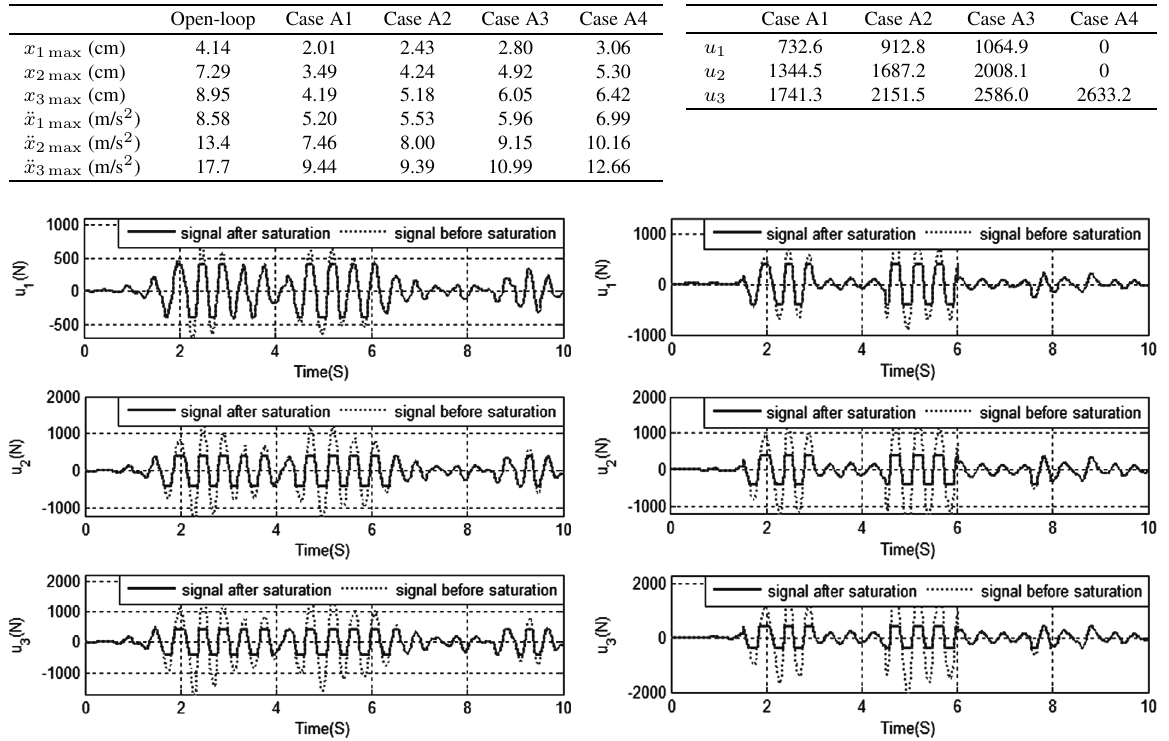
Table 2 The maximum control forces before saturation ( τ = 25 ms)